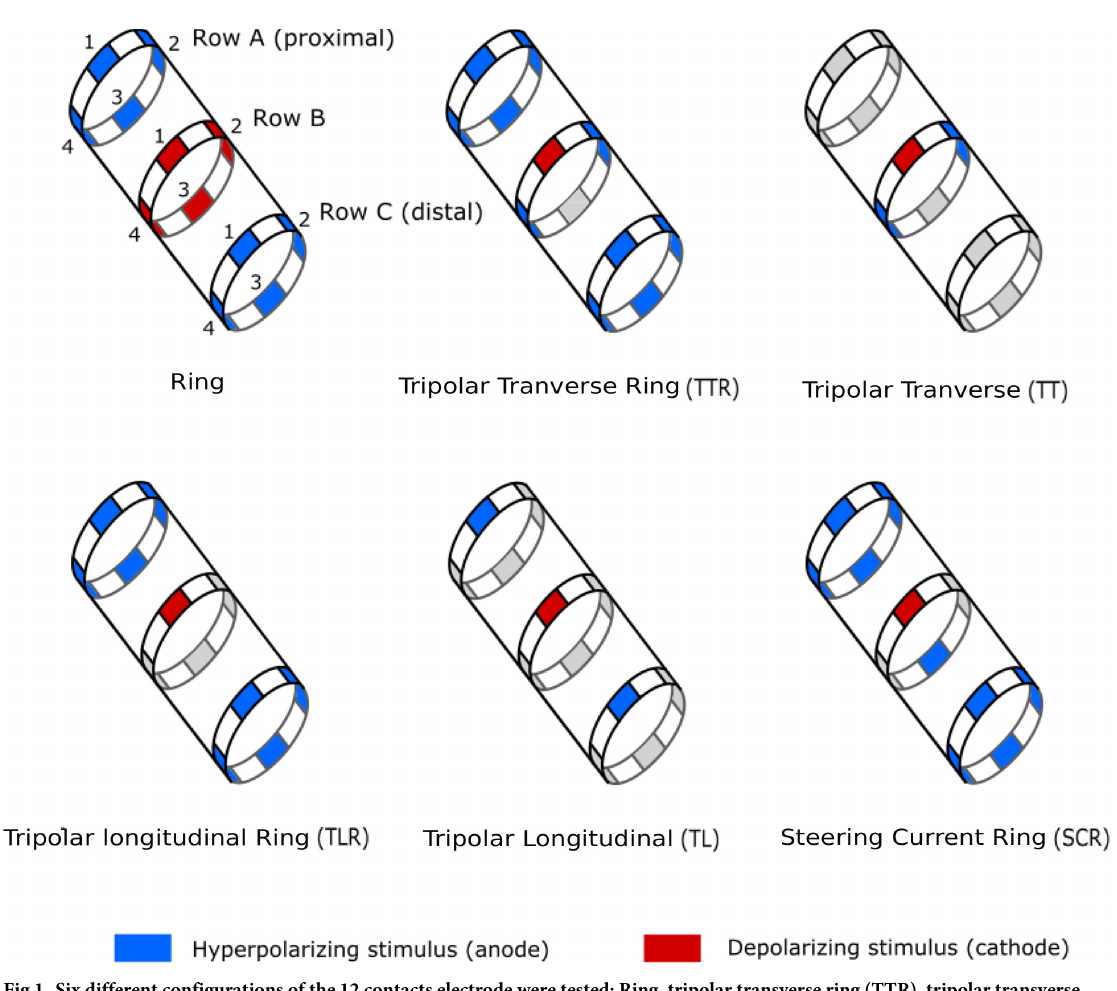
Fig 1. Six different configurations of the 12 contacts electrode were tested: Ring, tripolar transverse ring (TTR), tripolar transverse (TT), tripolar longitudinal ring (TLR), tripolar longitudinal (TL) and steering current ring (SCR). Each configuration is composed of a unique active site (cathode) on the central ring B (red) and several return path (anode, blue) for which the current ratio is imposed [9]. Only one electrode conformation is presented here (cathode position). The row A is proximal to the spinal cord whereas the row C is distal.